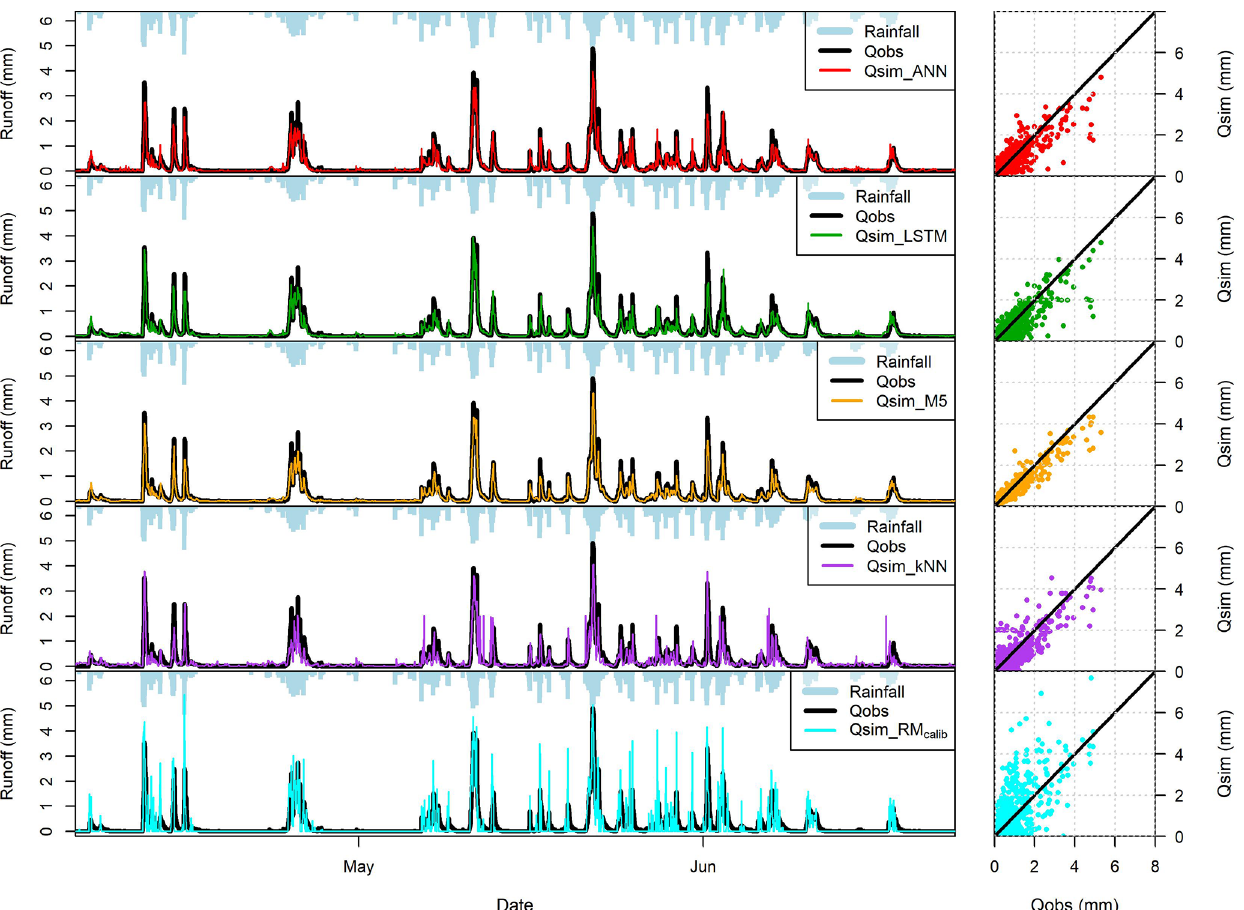
Figure 6. Performance of ML models on the testing period (BERG 2). The hydrographs were plotted for around 3-month period (2000h), while the Q–Q plots were plotted for the entire testing